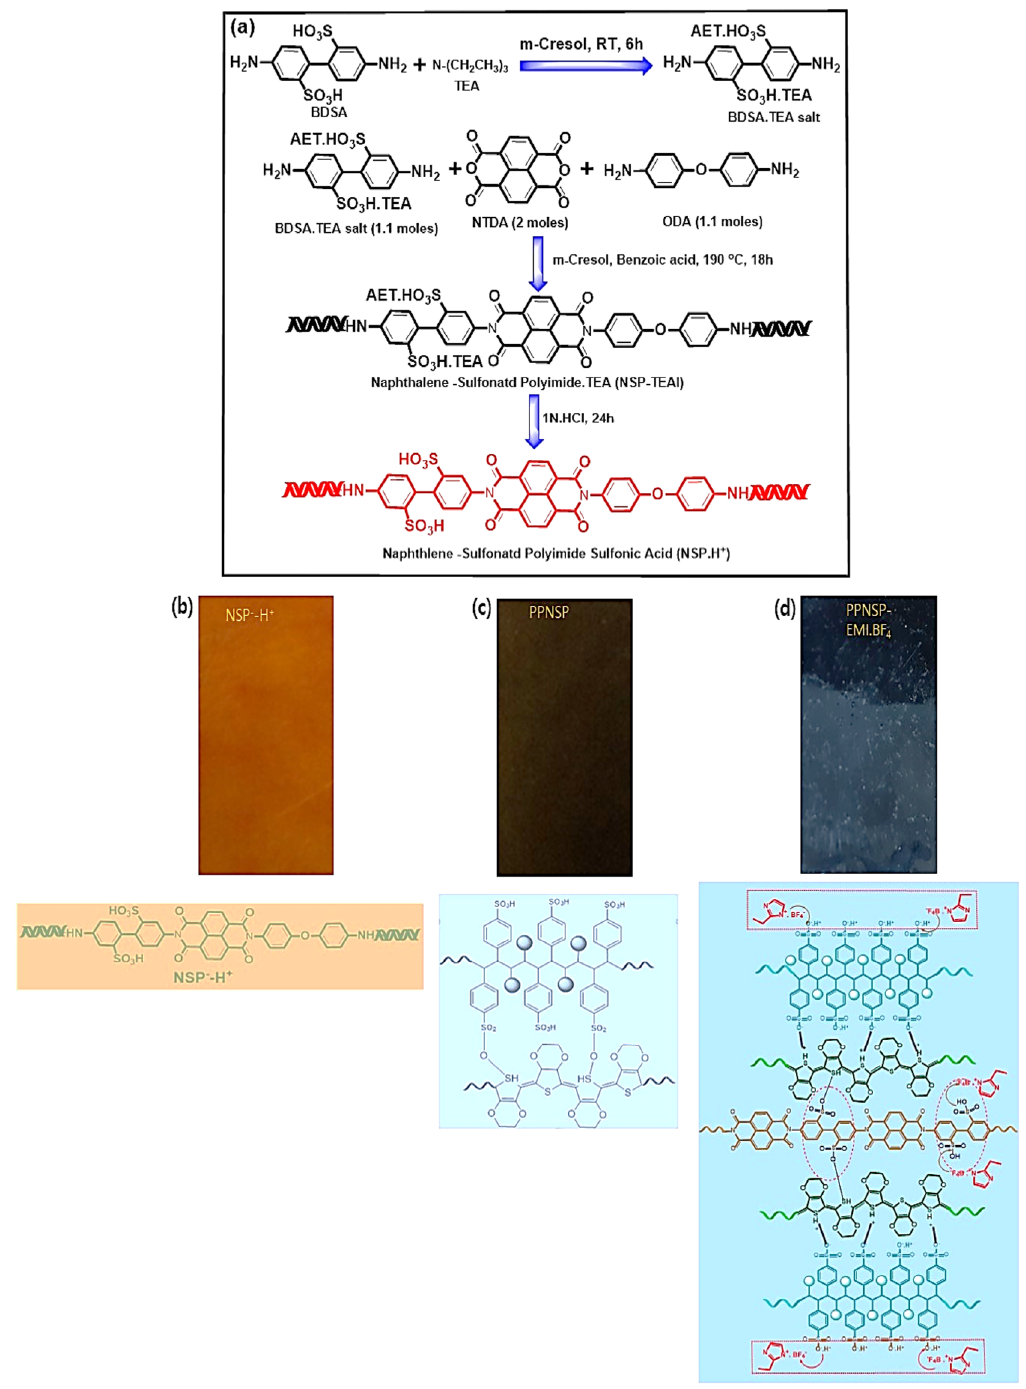
Figure 2. ( a ) Synthesis method of NSP.H + , and digital images and chemical structures of ( b ) NSP.H + , ( c ) conjugated conductive PEDOT: PSSa film; ( d ) ion hopping mechanism between PPNSP and EMI.BF 4 with strong ionic-ionic interactions between host PPNSP and guest EMI.BF 4 for generation of higher Voc and